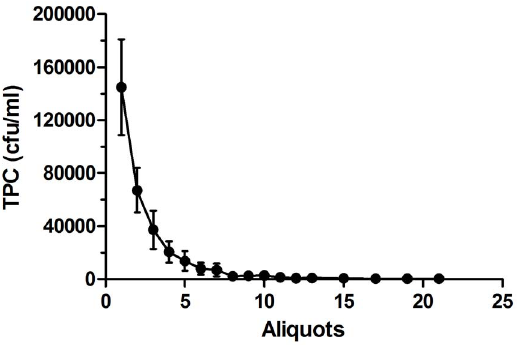
Fig. 2. TPC as a function of number of aliquots. From the first aliquot of 50 ml after turning on a shower, the TPCs of successive water aliquots each of 50 ml rapidly decimated. The first 4 points were based on 6 showers. Points 5 and 6 were based on 5 and 6 showers, respectively. The remaining points were based on 2 to 6 showers (mean 3.6). The mean number of showers during the whole experiment was 4.2. The same set of showers was used through the whole experiment. The bars indicate